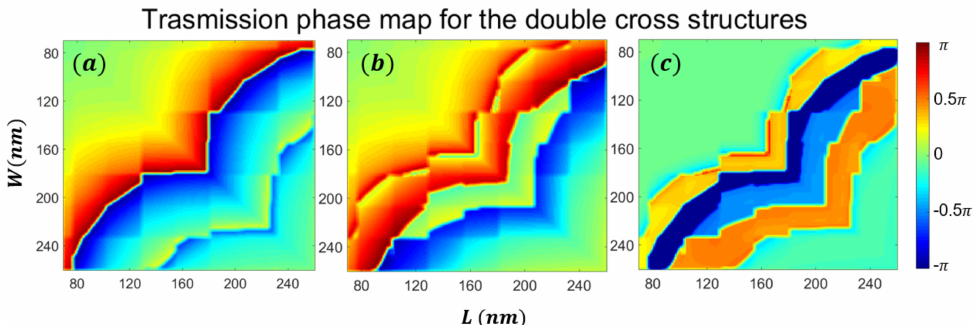
Figure 5. Transmission phase map of the double cross structures: ( a ) − 3.7 ◦ incident light; ( b ) 15 ◦ incident light; ( c ) The phase difference between ( a ) and ( b ). The unitcell’s size is 520 nm, the structure height (H) is 500 nm, the length (L) and the width (W) vary from 70–260